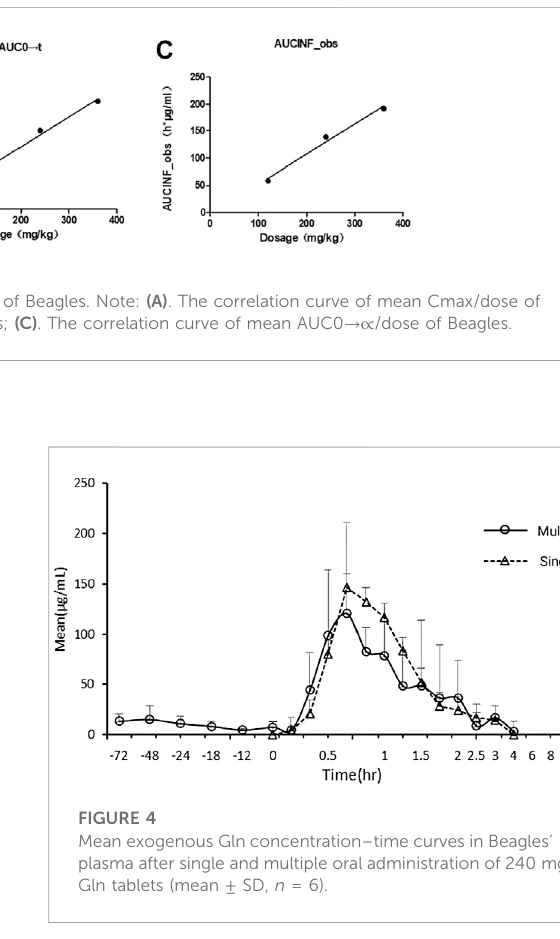
Figure 3, and the linear regression equation and determination coef fi cient r 2 were shown in Table 4.